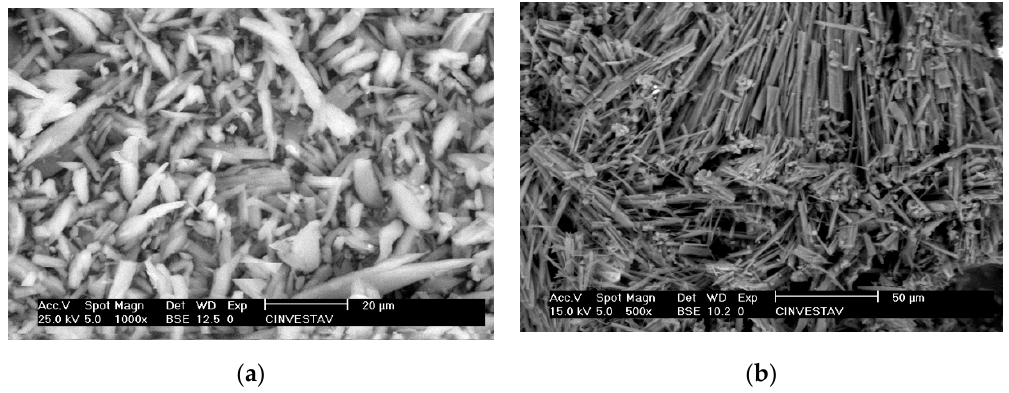
Figure 9. SEM images of the self-assembly strand-shaped structures of bisteroids esters: ( a ) 8a in EtOAc. ( b ) 10b in EtOAc.